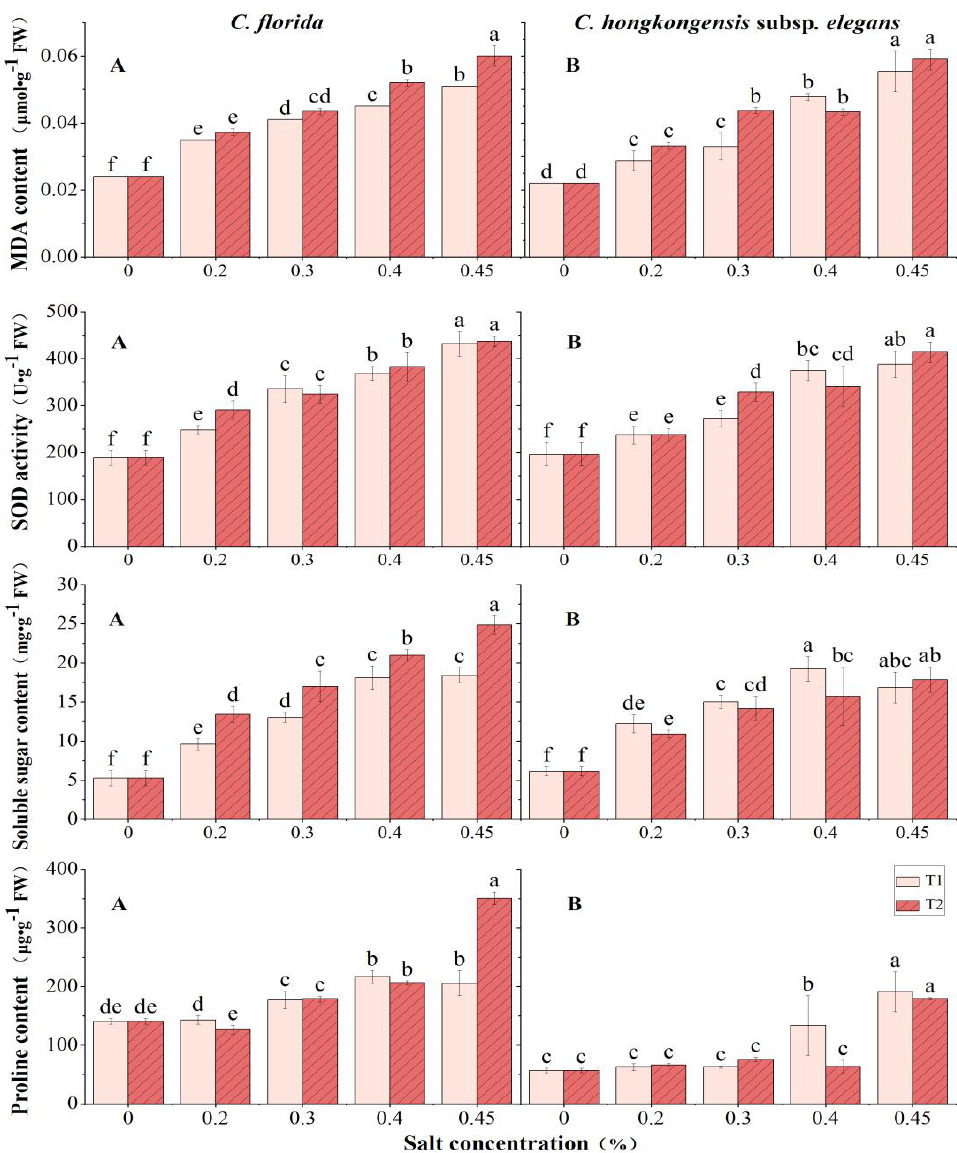
Figure 2. Responses of superoxide dismutase (SOD) activity, malondialdehyde (MDA), soluble sugar (SS), and proline (Pro) content in the shoot of seedlings of C. florida and C. hongkongensis subsp. elegans to salt stress. Different uppercase letters and lowercase letters indicate significant difference between species across different treatments and between treatments within each species, respectively, at p < 0.05 level. Each value is shown as the mean ± SD of four replicate measurements, as in Figure 3.